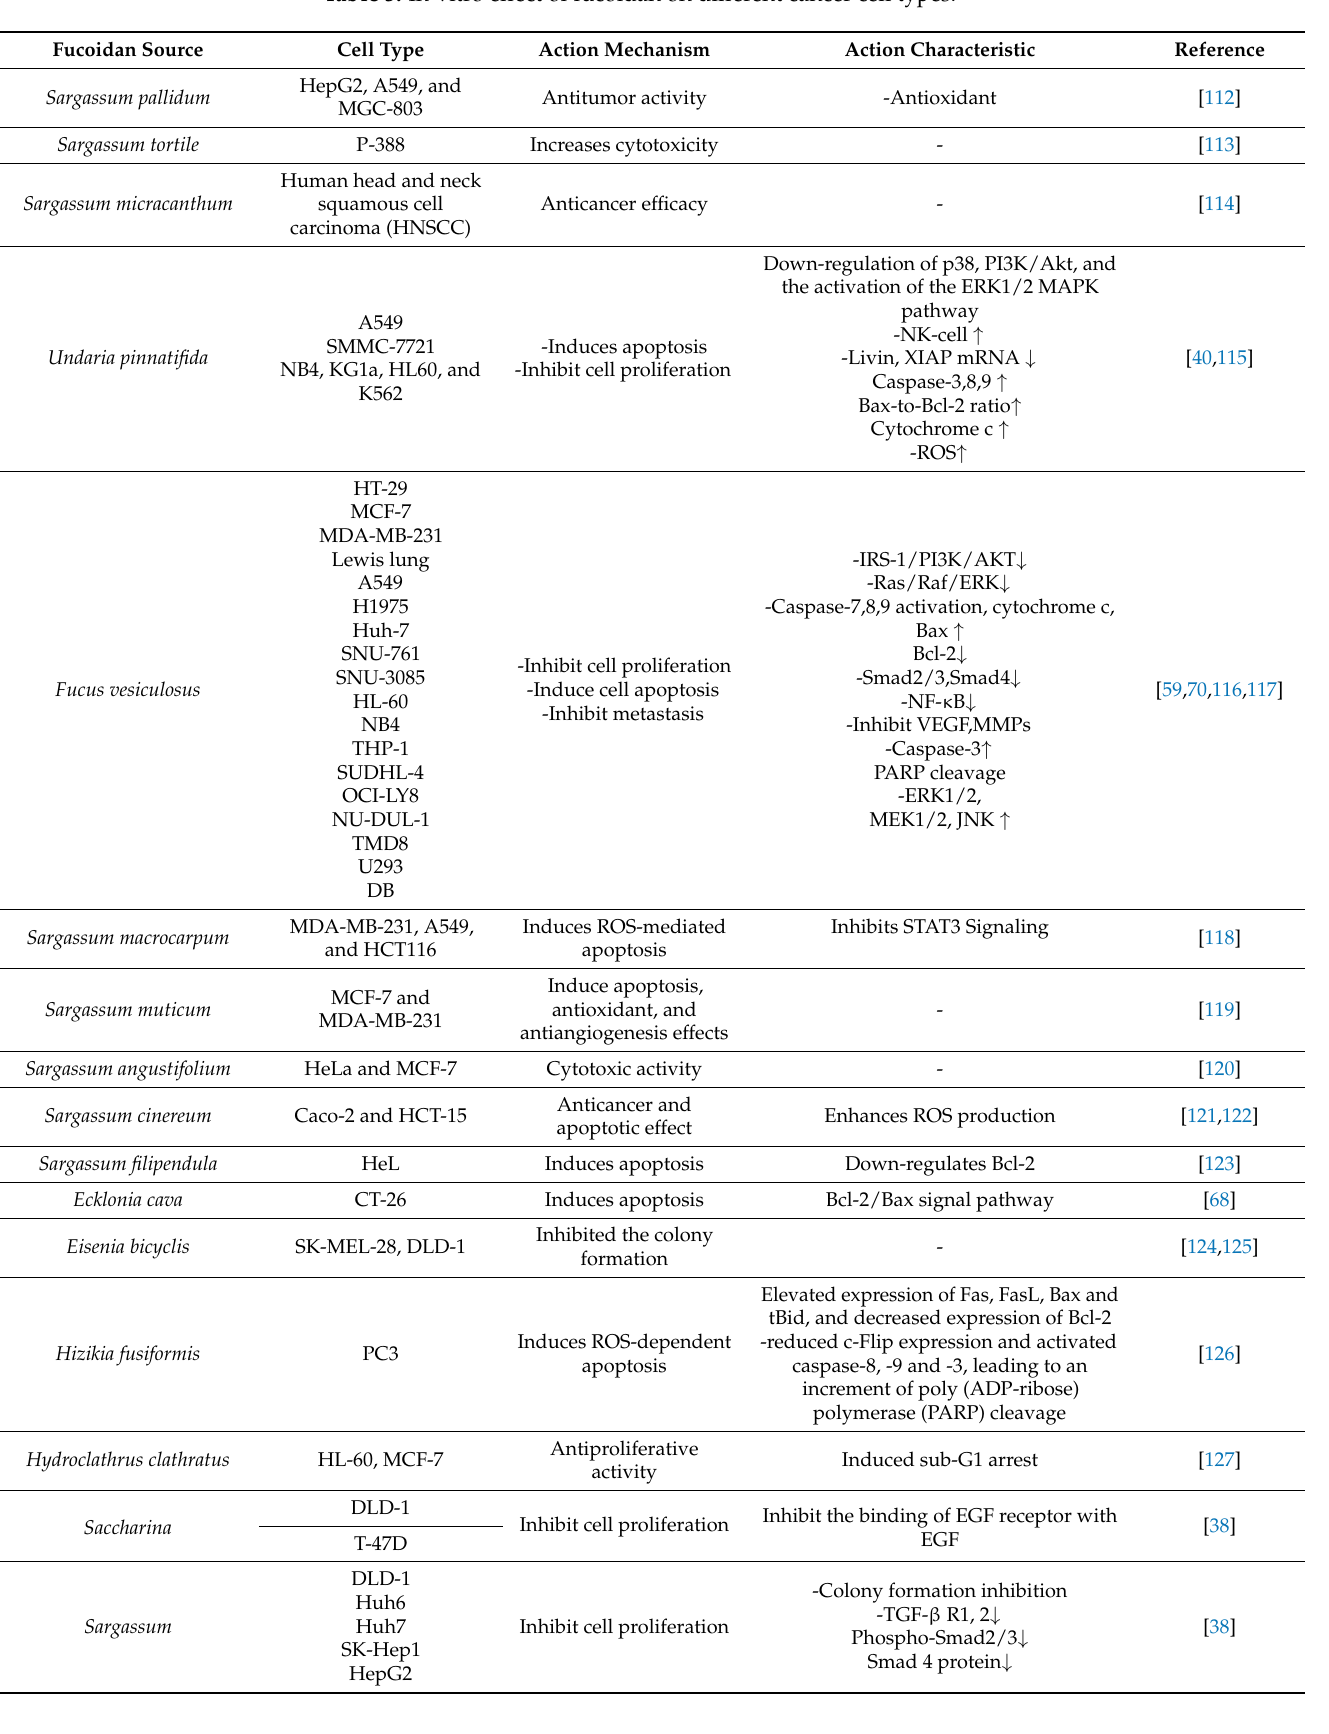
Table 3. In-vitro effect of fucoidan on different cancer cell